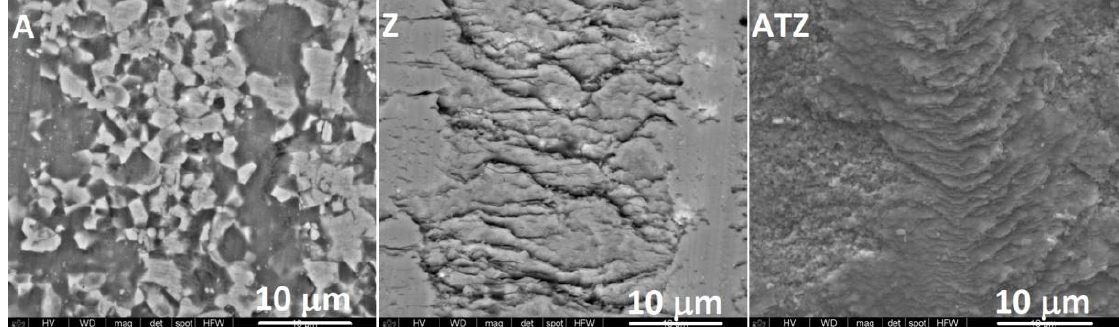
Figure 10. SEM images of the worn surfaces of the ATZ samples after the tribological test performed at temperatures indicated in top right corners of the figures. All magnification were the same. The marker bar indicates a 1 mm distance.